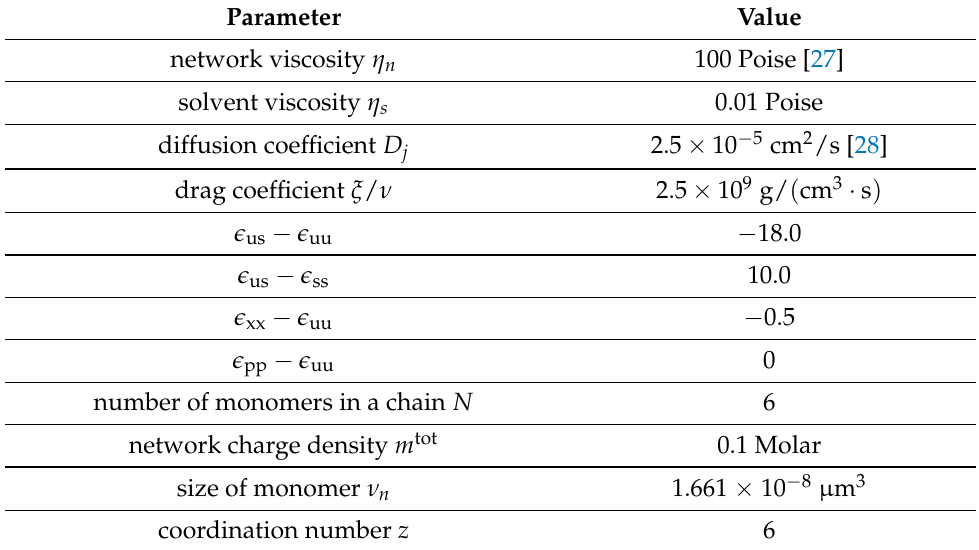
Table 1. Simulation Parameters. (cid:101) us , (cid:101) uu , (cid:101) ss , (cid:101) xx , and (cid:101) pp are the interaction energies nondimension- alized by k B T